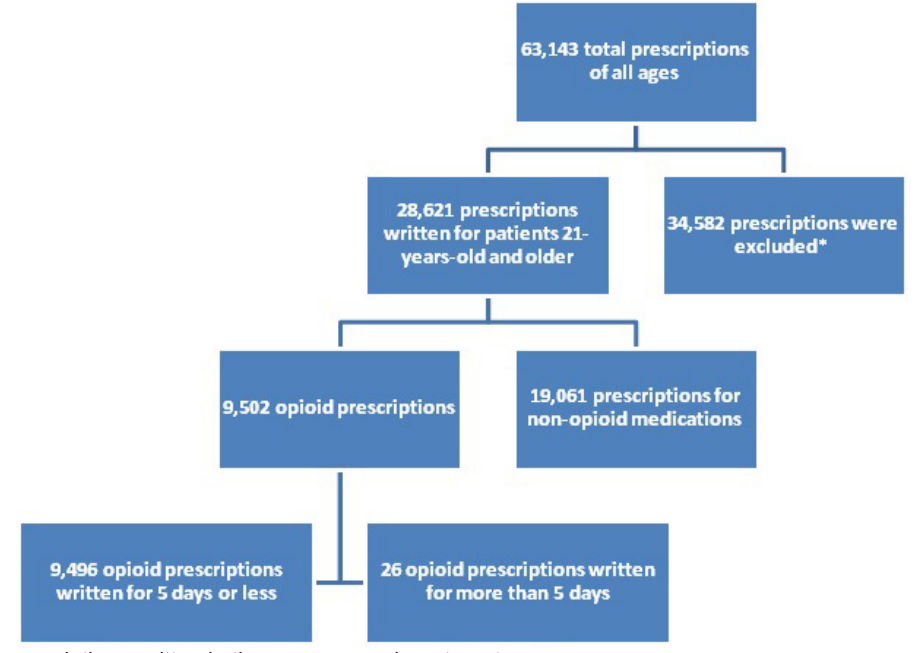
Figure 1 . Analysis of prescriptions written in the emergency department.